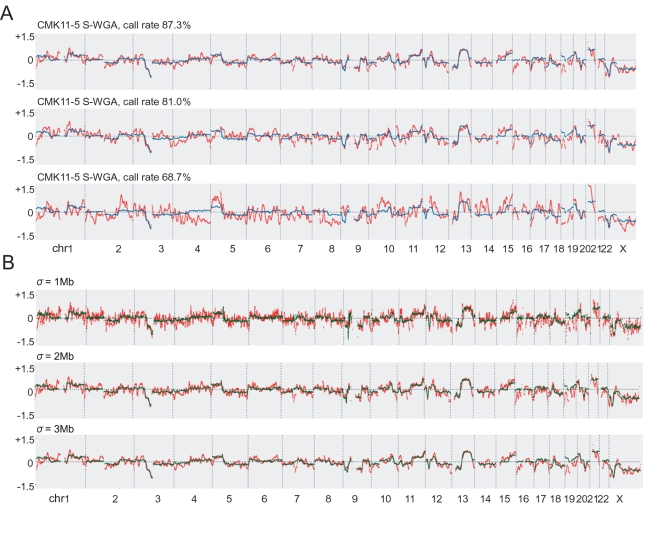
CCN analysis of the S-WGA products from the CMK11-5 cell line.(A) Results of the CCN analysis. A 3-Mb genomic smoothing size was used for analysis. Blue and red lines indicate CCN data of the non-amplified gDNA and S-WGA product, respectively. (B) Effect of the genomic smoothing size (σ) on the CCN analysis. Green and red lines indicate CCN data of the non-amplified gDNA and S-WGA product, respectively.